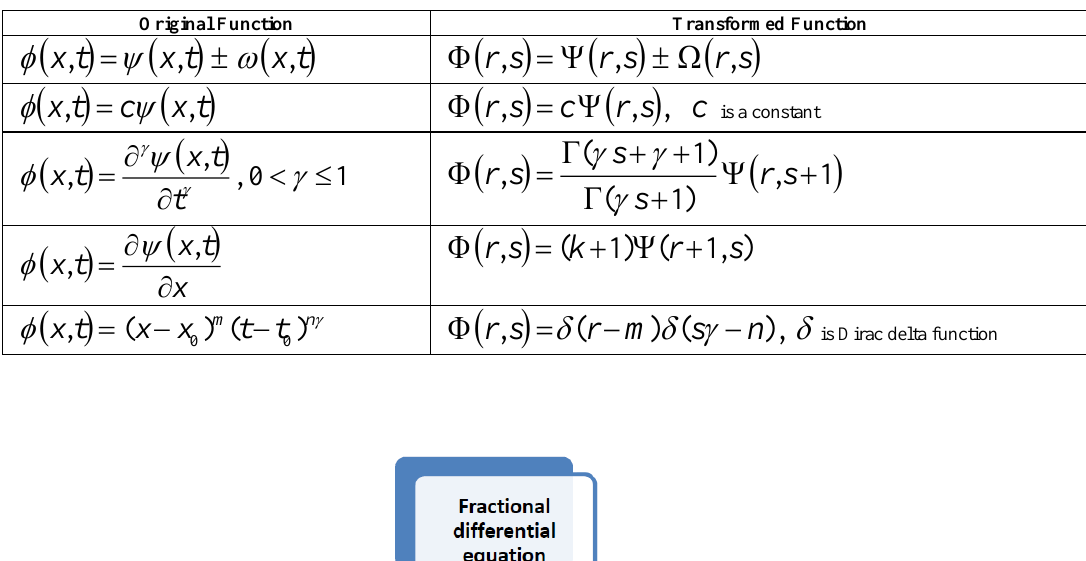
Table 6. Modified fractional differential transforms